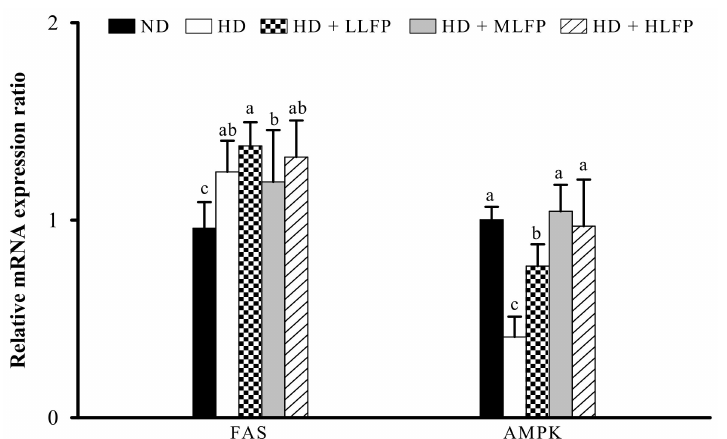
Figure 7. Effect of LFP on mRNA expression of genes related to lipid metabolism in the liver of rats fed a high-calorie diet. The mRNA expressions of FAS and AMPK were measured by quantitative real-time PCR. The significance of difference in mRNA expression of genes related to lipid metabolism was evaluated by Duncan’s test. Data are the means ± SD ( n = 5). Different letters (a–c) indicate that the mRNA expression was statistically different from each other ( p < 0.05). The groups are abbreviated as: Normal diet (ND), high calorie diet (HD), HD with low LFP (HD+LLFP), HD with medium LFP (HD+MLFP), HD with high LFP